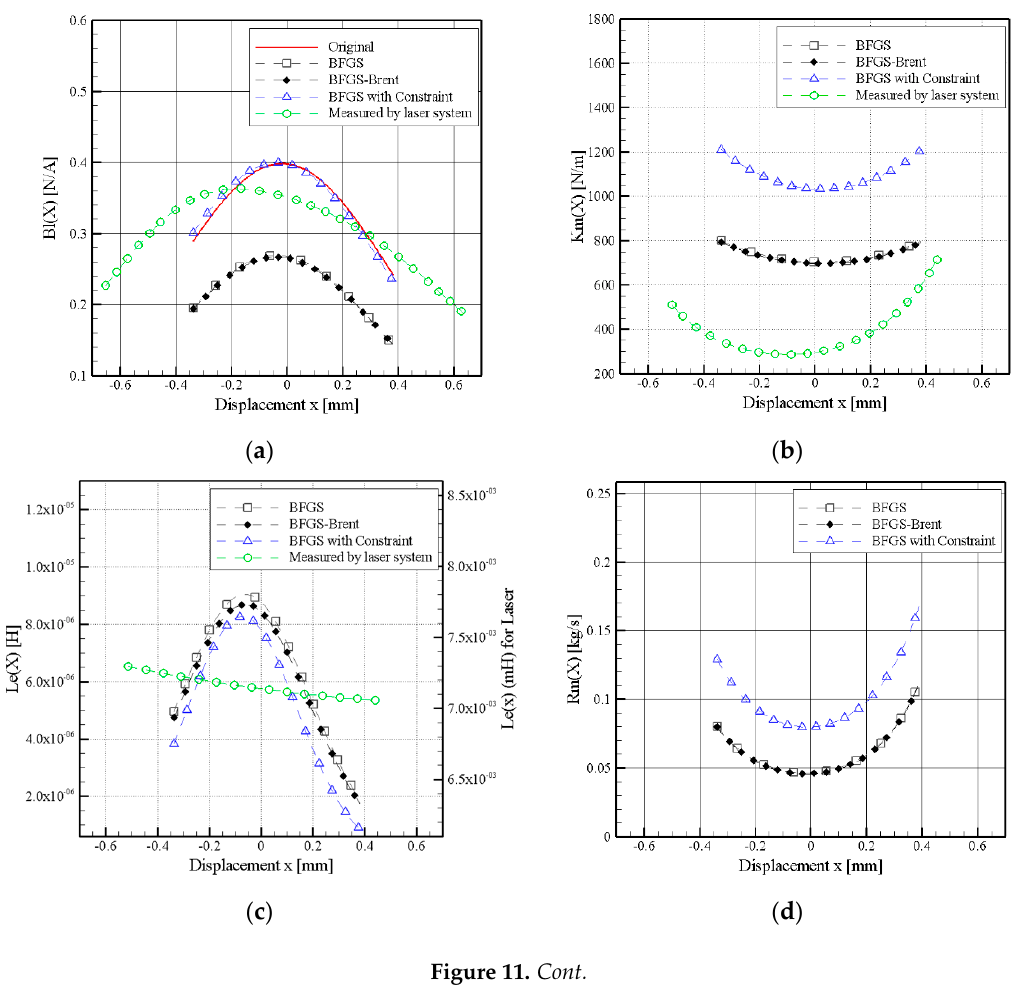
Figure 10. Comparison of displacement data simulated by the model and displacement measured by using the capacitance and laser displacement measurement